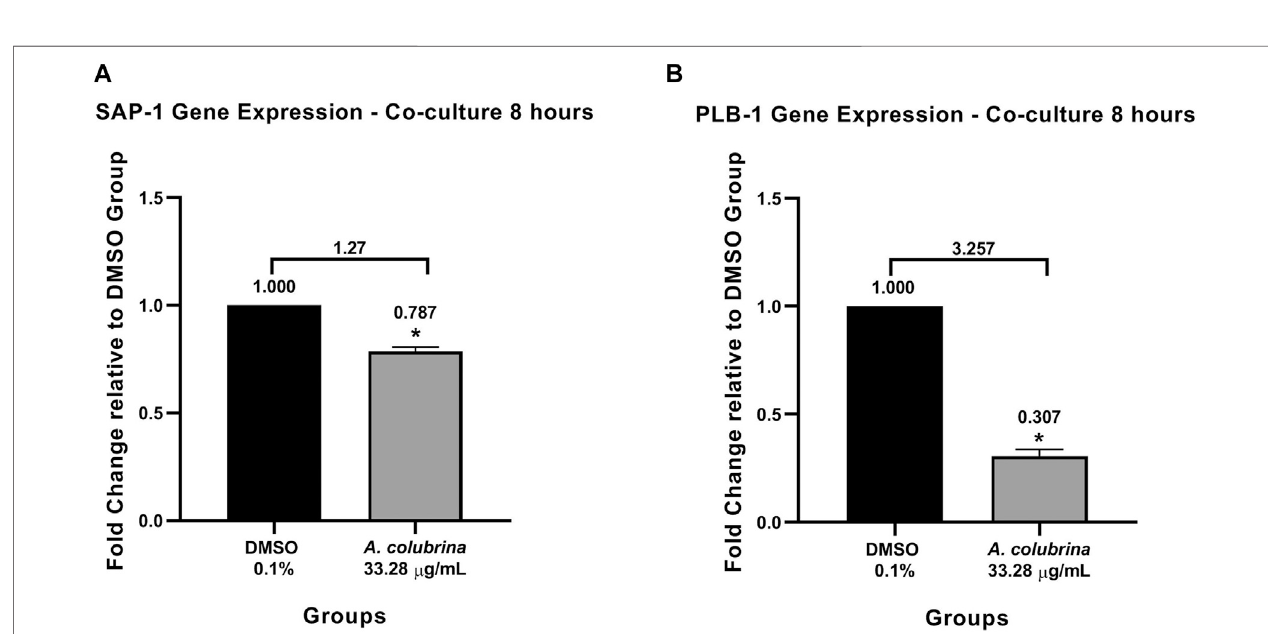
FIGURE4| Real-timequantitativeinformationabout relative gene expression of (A) SAP-1 and (B) PLB-1 after 8 h oftreatment with A. colubrina extract treatment (33.28 μ g/ml)inhumangingival fi broblastsinfectedby C.albicans .DMSO0.1%:vehiclecontrol.Valuesshownwithasterisk(*)arestatisticallysigni fi cantwhencompared to the vehicle control ( p <